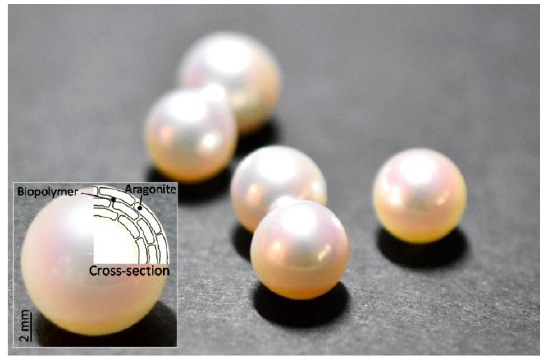
Figure 4. Internal structure diagram of nucleated pearls